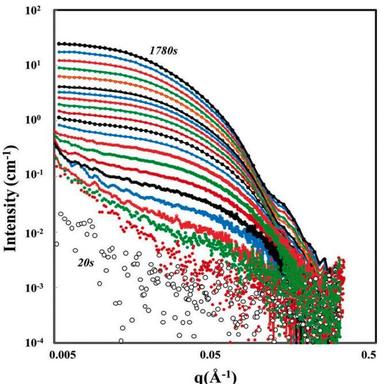
Evolution of scattering patterns with time due to gold nanoparticle growth. Reprinted with permission from. Copyright 2012 American Chemical Society. (For interpretation of the references to colour in this figure legend, the reader is referred to the web version of this article.)